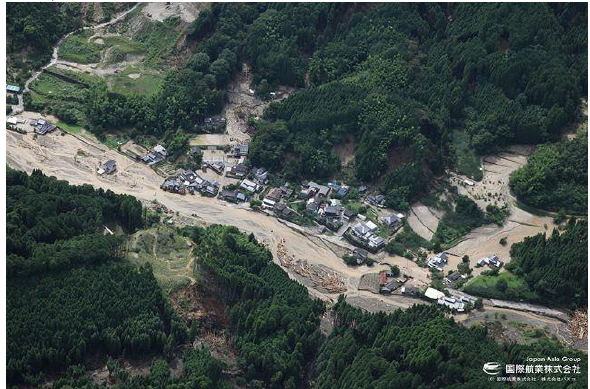
Figure 1. River flooding due torrential